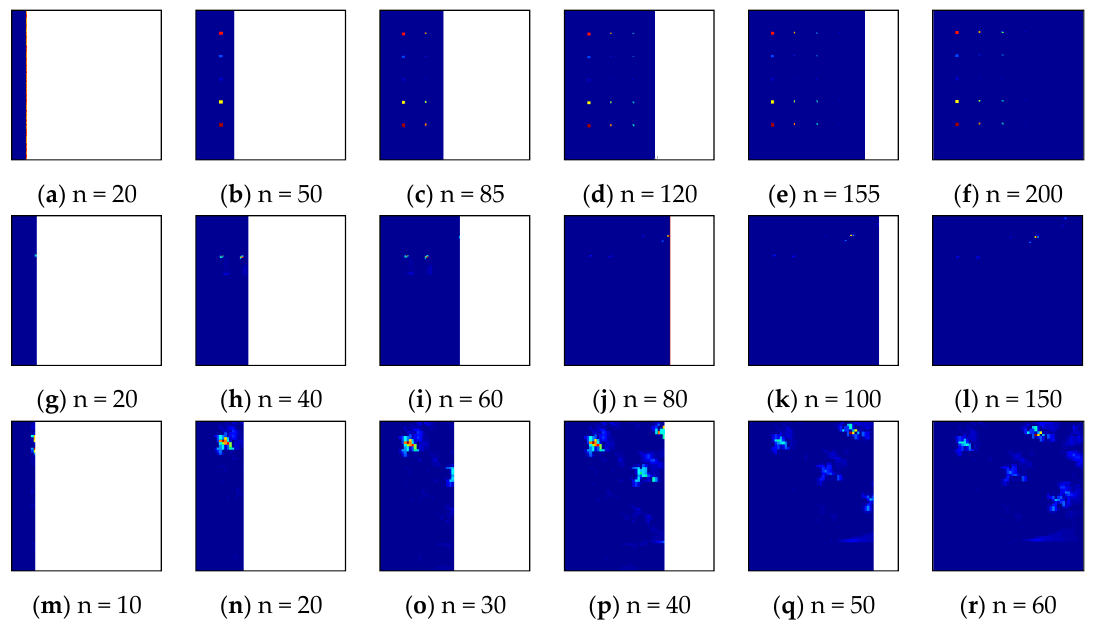
Figure 14. Real-time progressive procedures of PLPKRXD on the three HSI datasets. ( a – f ) Synthetic dataset; ( g – l ) Pavia Center dataset; ( m – r ) San Diego Airport dataset.